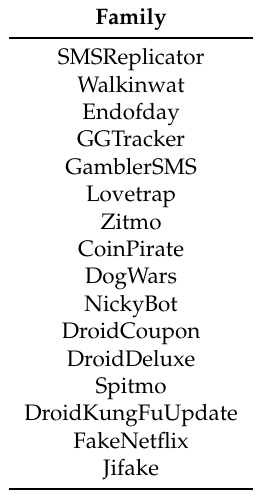
Table 5. Malgenome dataset families with one